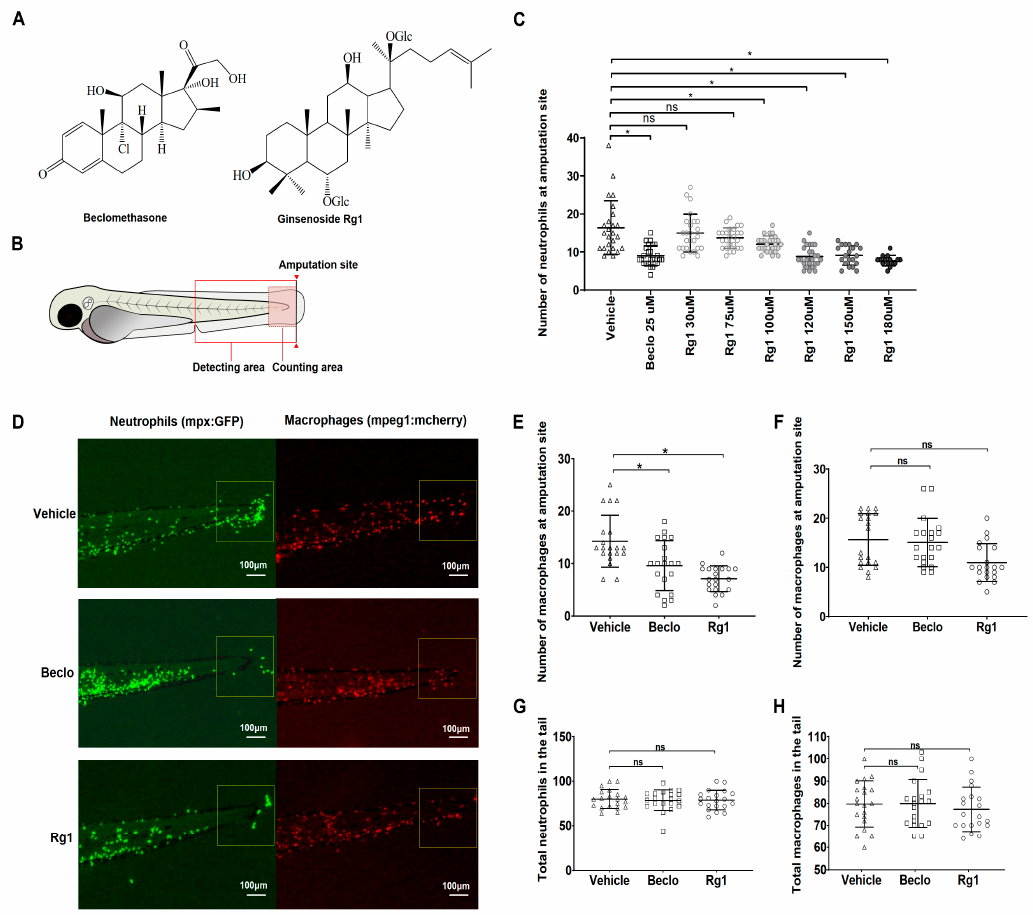
Figure 1. Inhibitory e ff ects of Rg1 and beclomethasone on wounding-induced leukocyte migration. ( A ) The chemical structures of the classical GC beclomethasone, and the ginsenoside Rg1, which has a steroid-like skeleton consisting of four trans-rings, (three six-member cyclohexane rings and one five-member cyclopentane ring). ( B ) Schematic drawing of a zebrafish larva at 3 dpf, indicating the site of tail fin amputation, the region of microscopic imaging, and the area for quantification of neutrophils and macrophages (i.e., the counting area: posterior to the tail vein). ( C ) Dose-dependent anti-inflammatory e ff ect of Rg1. Numbers of neutrophils that have migrated towards the amputated tail fin at 4 hpa and 2 h pre- and 4 h post-treatment with Rg1 or beclomethasone at the indicated concentrations. The graph shows data from an experiment with 25 larvae per group, representative of three experimental repeats. No mortality was observed at Rg1 concentrations up to 120 µ M, while 20% and 40% of embryos on average died in the 150 µ M and 180 µ M groups. ( D ) Representative fluorescence microscopy images of wound-induced migration of neutrophils (in green fluorescence channel) and macrophages (in red fluorescence channel), in combination with vehicle,